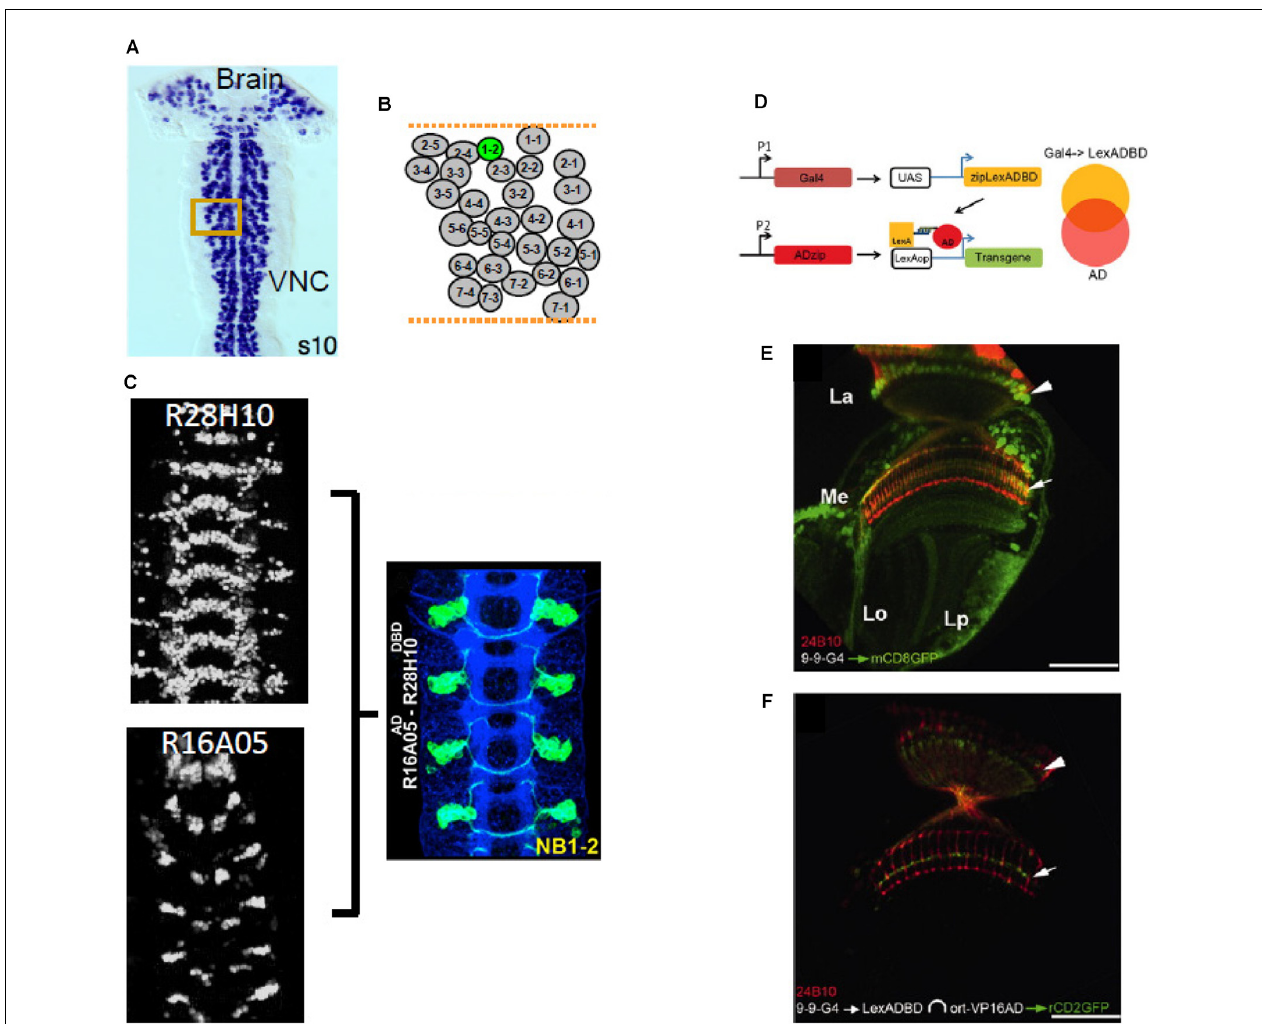
FIGURE 8 | Split Gal4 applications in neurodevelopment and technical spinoffs. (A–C) Split Gal4 has been used to target neurons in specific neuronal lineages. (A) Larval neurons, some of which persist into adulthood, are born embryonically from neural stem cells called neuroblasts (NBs). Each hemisegment in the ventral nerve cord (VNC), has a similar complement of identified NBs, arranged in rows and columns. (B) Diagram of the arrangement of the NBs in a VNC hemisegment, with NB1–2 highlighted in green. (C) Two CRM-Gal4 lines (left panels) overlap in expression in NB1–2, as indicated by the Split Gal4 driver made using the two CRMs (right panel). Neuronal progeny of NB1–2 is labeled with GFP (green). (D–F) The Split LexA system uses the same heterodimerizing leucine zippers as Split Gal4. (D) Using a UAS-Zip − -LexADBD, a Gal4 expression pattern can be converted into a Split LexA expression pattern. Where this pattern intersects with the expression pattern of a Zip + -VP16AD driven by its own enhancer (P2), a functional LexA::VP16AD transcriptional activator is produced and LexA op -mediated transgene expression occurs. (E) The 9–9-Gal4 driver expresses in multiple subsets of optic lobe neurons, including the Ort-positive, L3 neurons of the lamina (somata, arrowhead; axon terminals, arrow). (F) The L3 neurons can be isolated by using 9–9-Gal4 to drive UAS- Zip − -LexADBD in combination with an ort-driven Zip + -VP16AD hemidriver. Red, 24B10 immunolabeling. Panel (A) from Luan et al. (2020); panel (C) adapted from Lacin and Truman (2016); panels (D–F) from Ting et al.